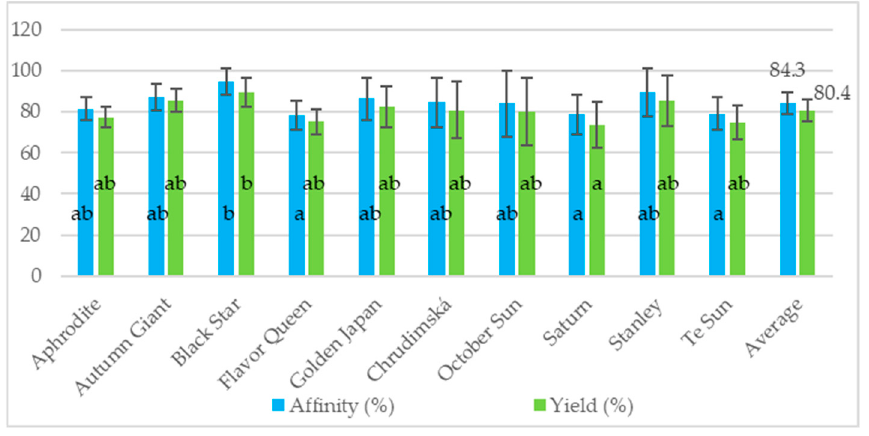
Figure 4. A comparison of the average values for root suckering and shoot formation on the stem of the saplings, by variety used. Small letters indicate statistically different homogeneous subgroups. Statistical analysis revealed that some of the analyzed traits were significantly influenced by the year of evaluation (Table 4). These traits were affinity ( p < 0.01) and yield of saplings ( p < 0.01). However, due to significant differences in rootstock–variety combinations at affinity and yield of saplings, the evaluation of interactions between year–rootstock–variety would be complicated and extensive. For this reason, only the annual average values of traits with classification to homogenous subgroups are shown in Table 4. Table 4. Average trait values in individual years and statistical significance.